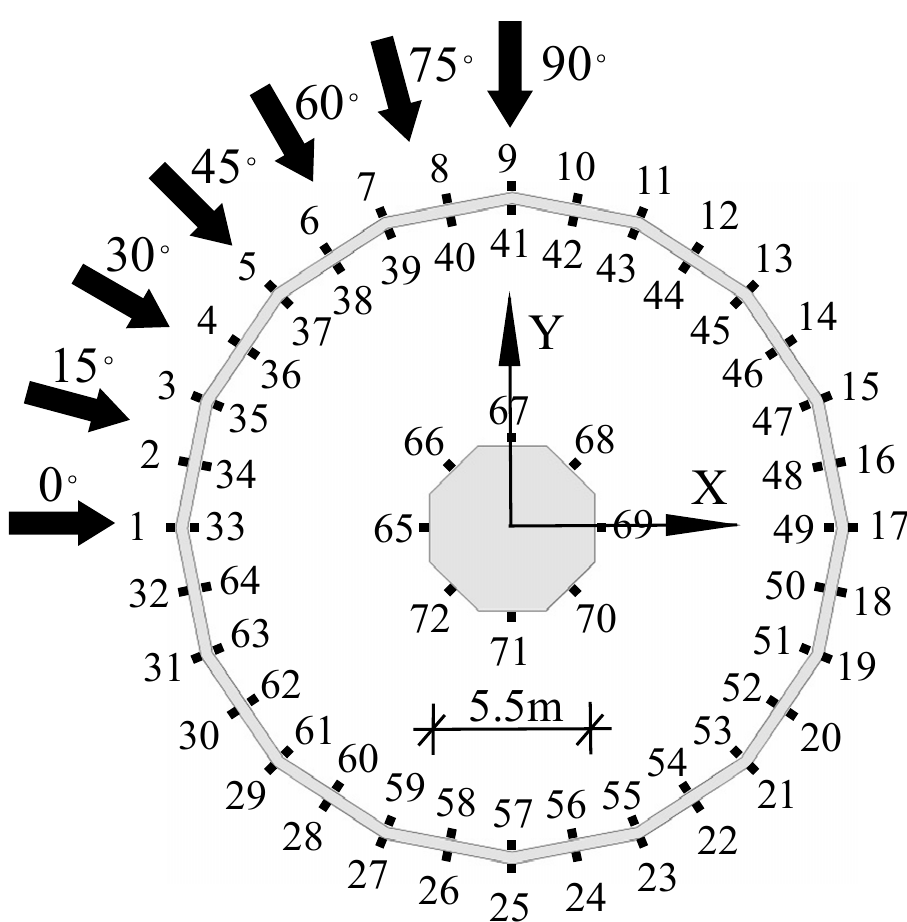
Figure 3. Arrangement of the measuring points on the 25 m layer and the definition of wind direction angles.